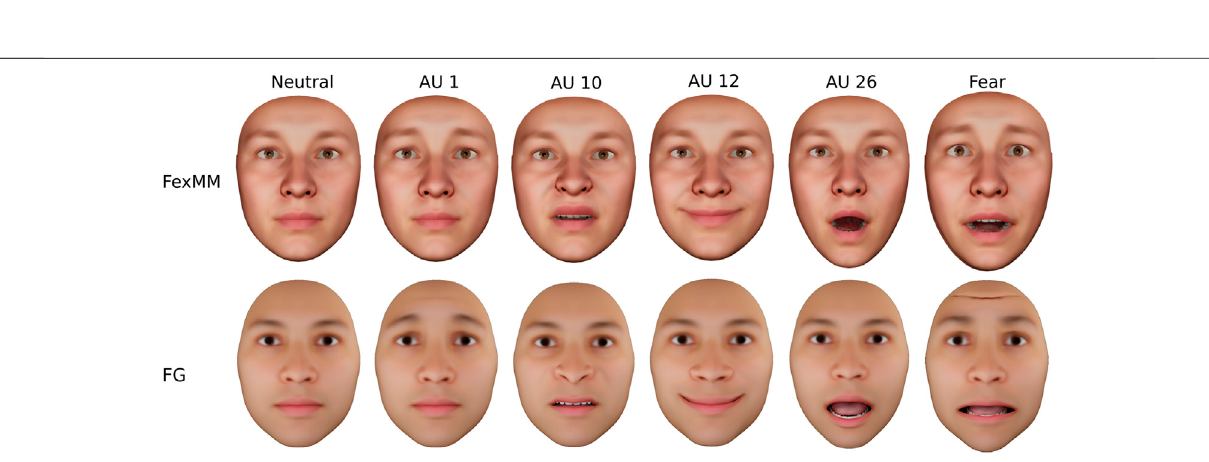
Frontiers in Virtual Reality |